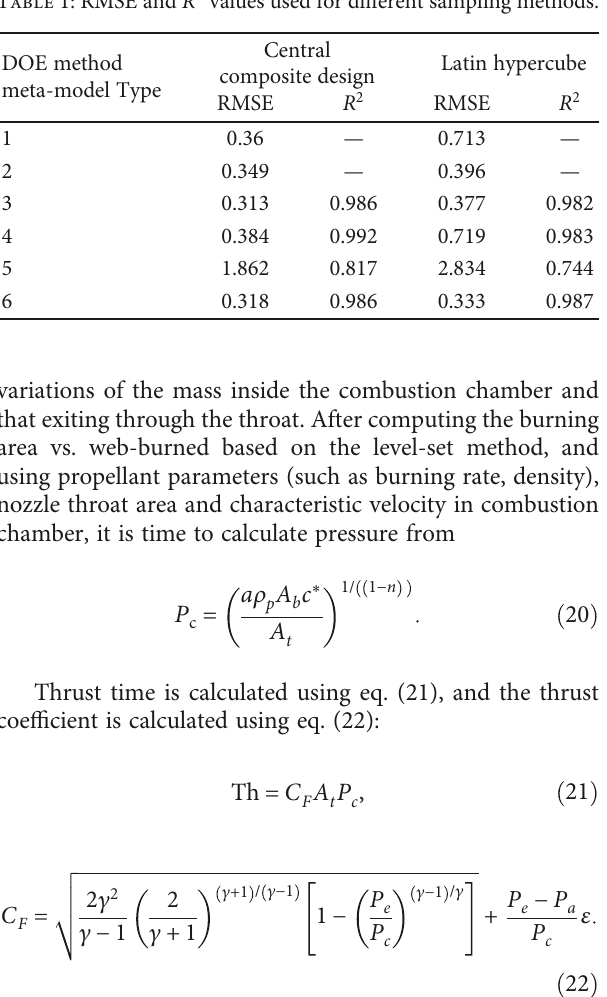
Table 1: RMSE and R 2 values used for di ff erent sampling